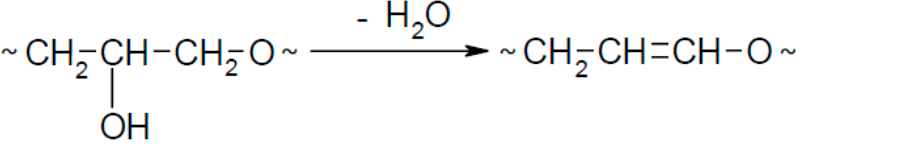
Figure 3. MALDI-ToF spectrum of polyol.